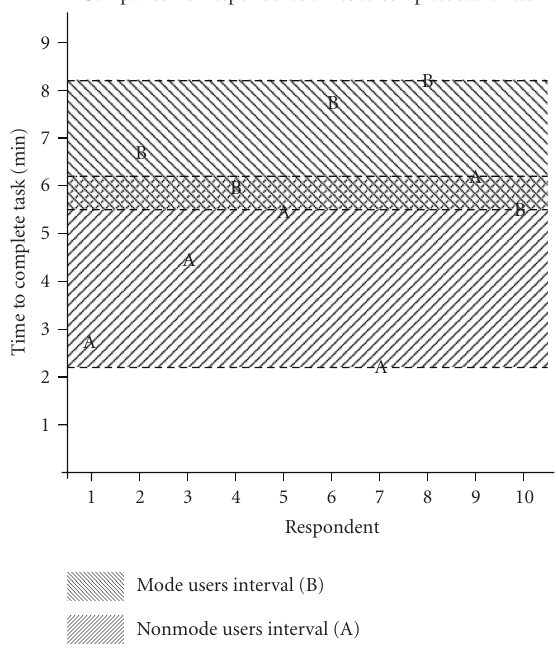
Figure 7: Diagram showing how long it took the respondents to find the information sought. Group A used “Nonmode”, while Group B used “Shopping